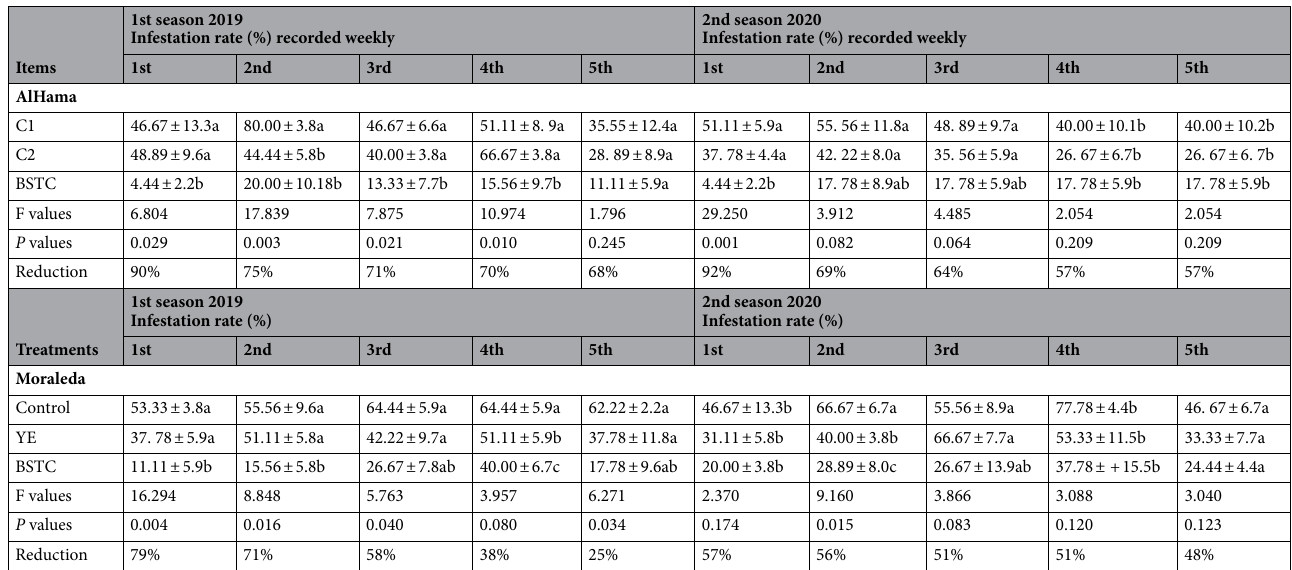
Table 2. Scoring infestation reduction form L. trifolii on foliar-sprayed P. vulgaris plants. Averages with no common letters have a significant difference at the 0.05